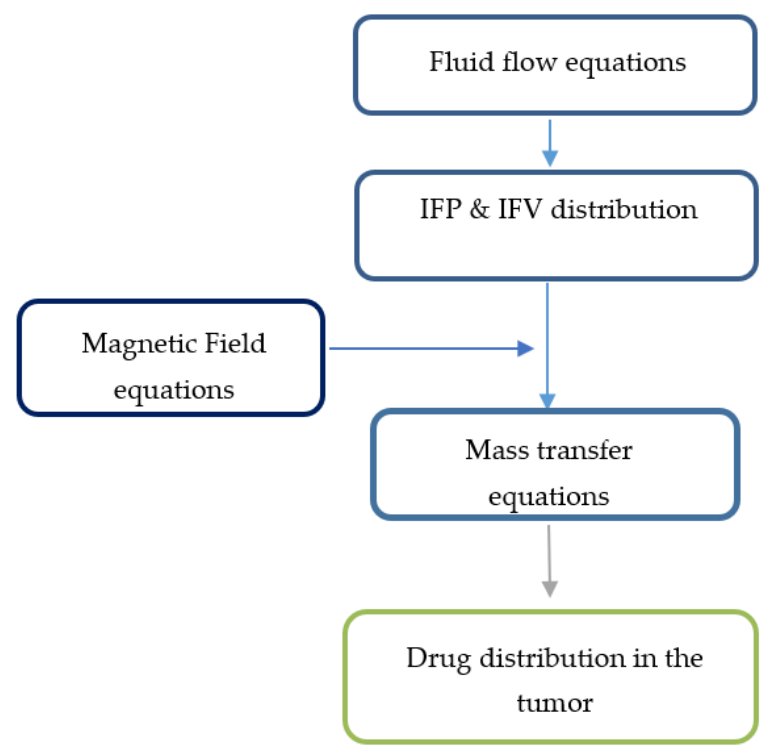
Figure 3. Solution strategy for the magnetically controlled IP drug targeting model.